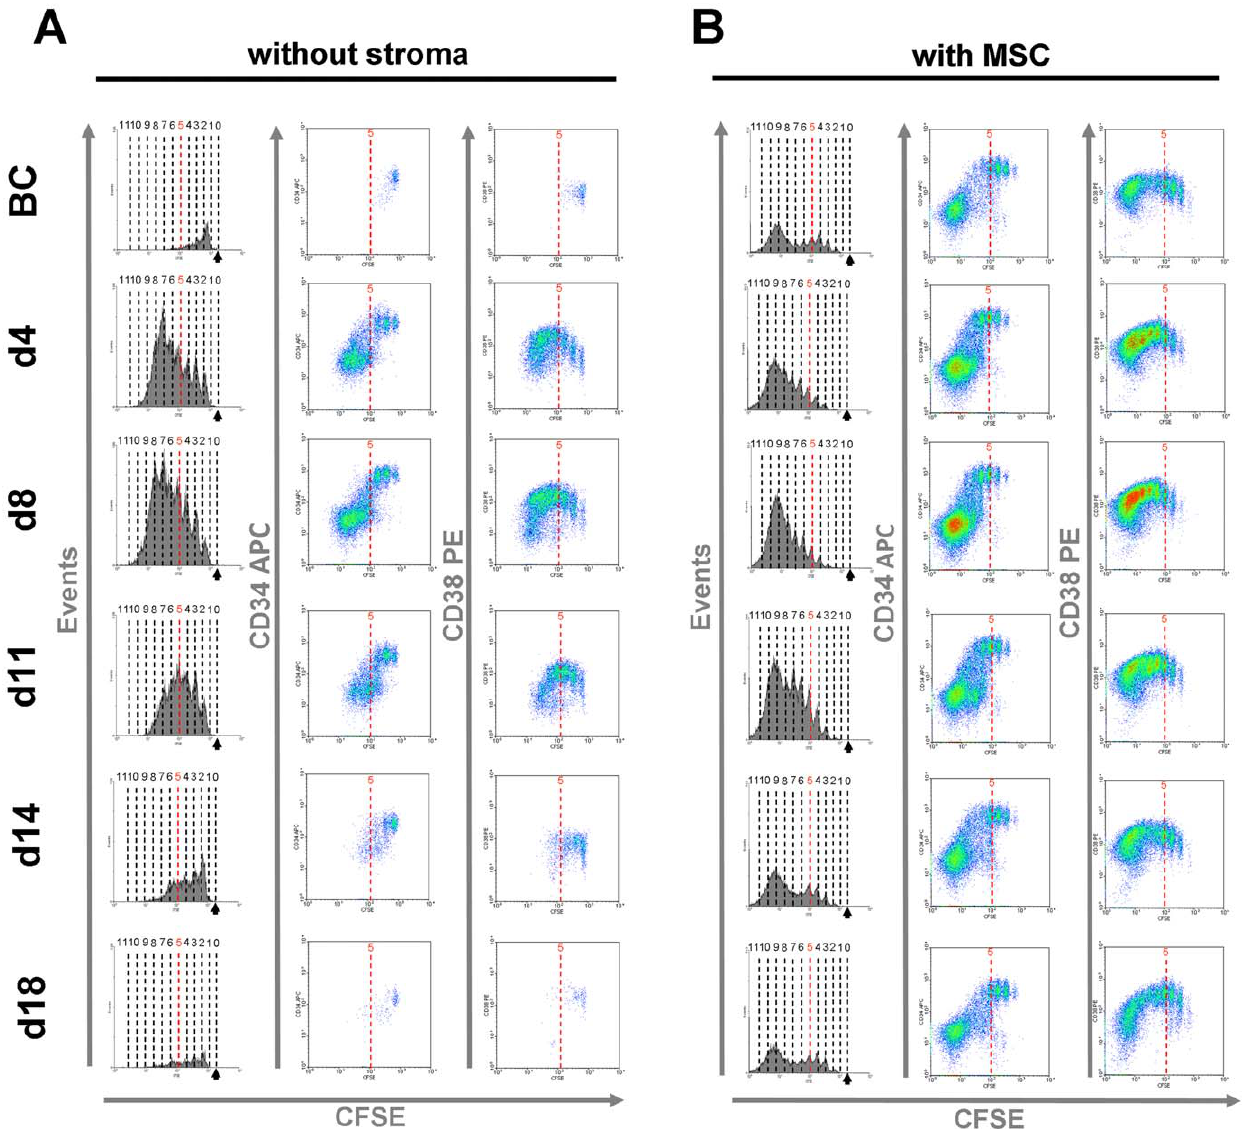
Figure 2. Proliferation and immunophenotype of HPC upon expansion with serum samples. CD34 + hematopoietic progenitor cells (HPC) were stained with CFSE and subsequently cultivated for seven days in vitro either without stromal support (A) or with MSC (B). Culture medium was supplemented with serum samples taken before chemotherapy (BC) or at different time points after HSCT (d4, d8, d11, d14 and d18). Flow cytometric analysis was used to monitor cell division history by residual CFSE staining (red line indicates five cell divisions). CD34 and CD38 expression was analyzed in relation to the number of cell divisions. Representative histograms for analysis of all nine patients are demonstrated.